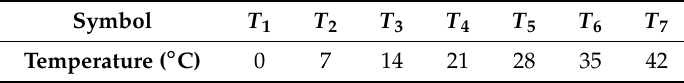
Table 3. The temperature points set by the thermal chamber.